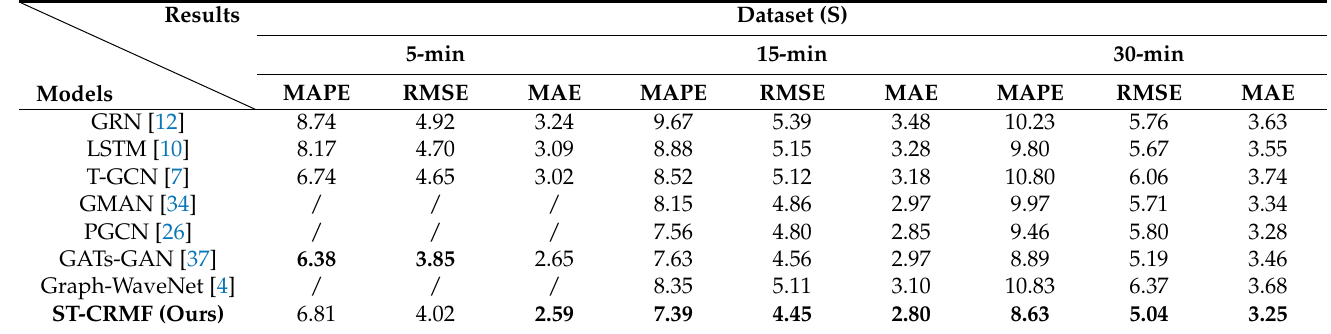
Table 2. Prediction results of the ST-CRMF and baseline models on the Seattle-Loop